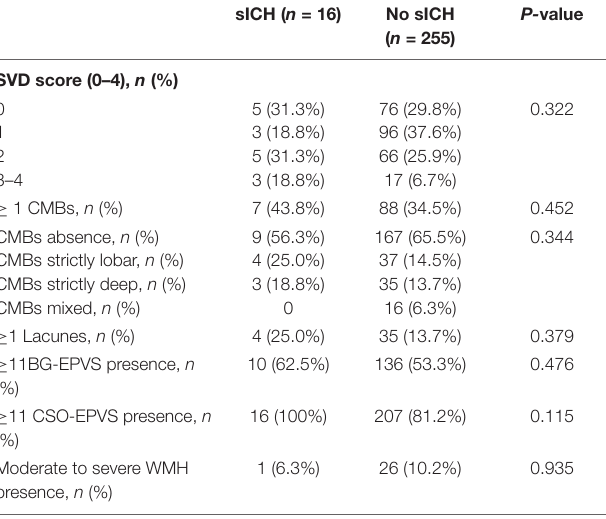
TABLE 3 | Baseline clinical and radiological characteristics for patients with and without